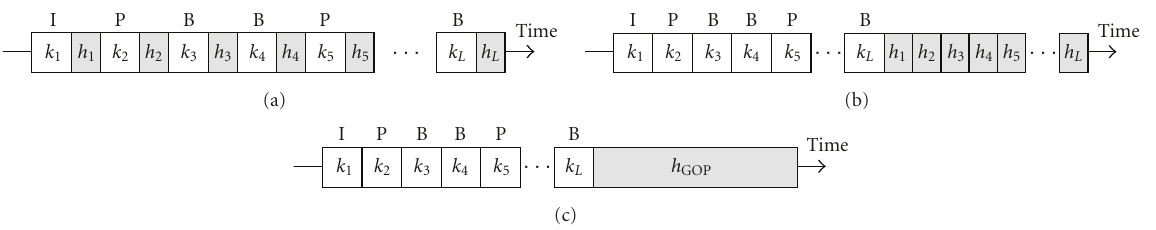
Figure 5: Sequence of source and FEC redundant packets: (a) instant frame-level FEC; (b) optimal frame-level FEC; (c) GOP-level FEC.